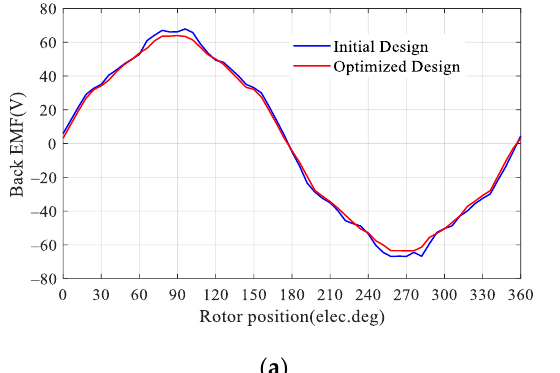
Figure 12. Open-circuit phase back EMF comparisons. ( a ) Waveform; ( b ) harmonic spectra.